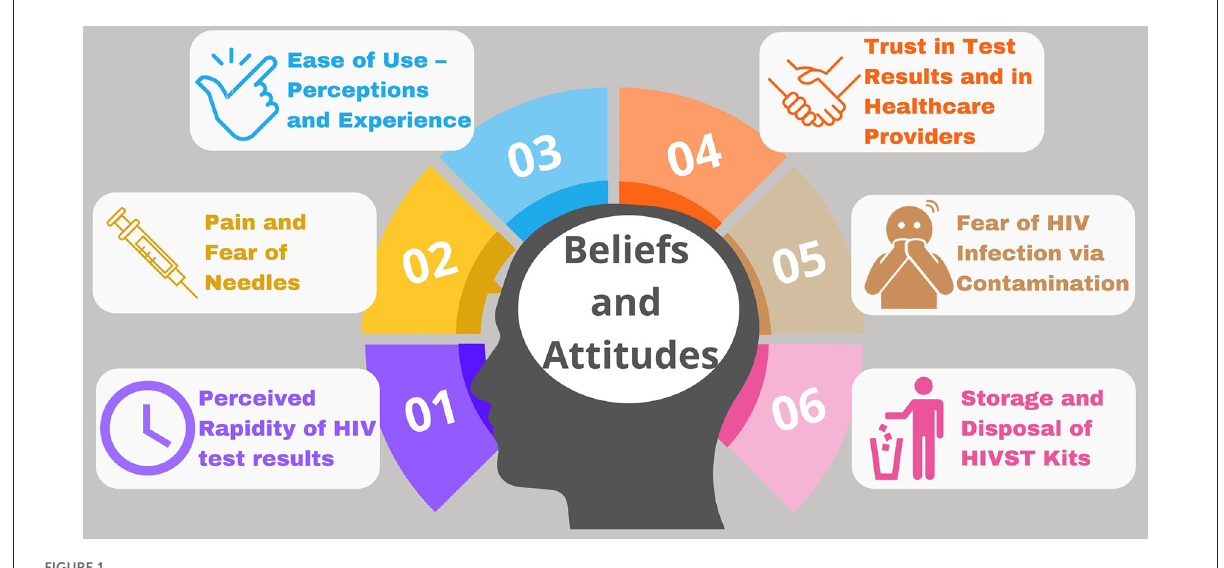
FIGURE1 Attitudes, beliefs, and preferences—key